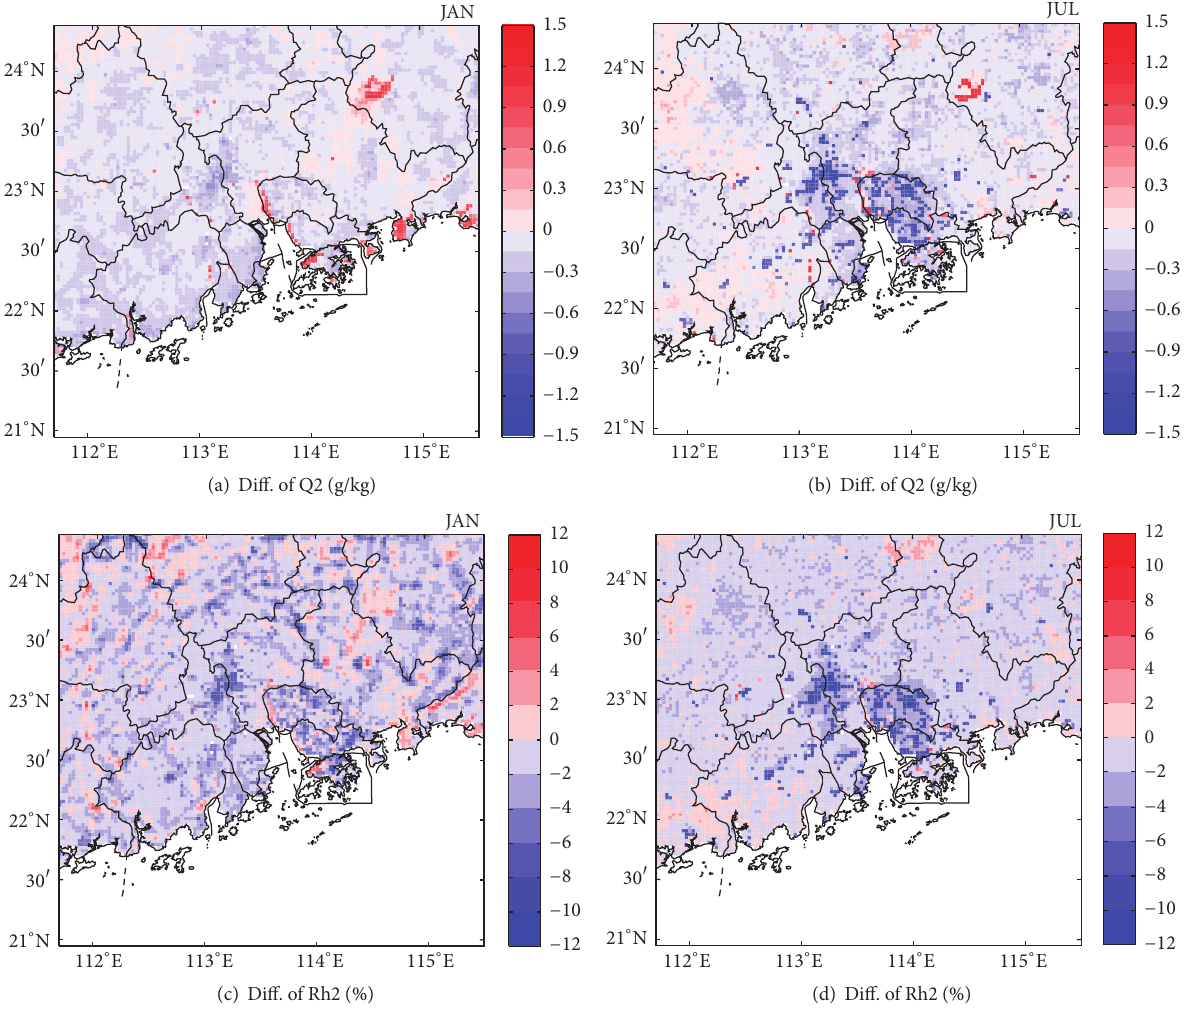
Figure 4: Spatial distribution of monthly-average Q2 differences (g/kg) (a, b) and Rh2 differences (%) (c, d) between the GLC2009 case and the GLC2000 case (differences = GLC2009 −